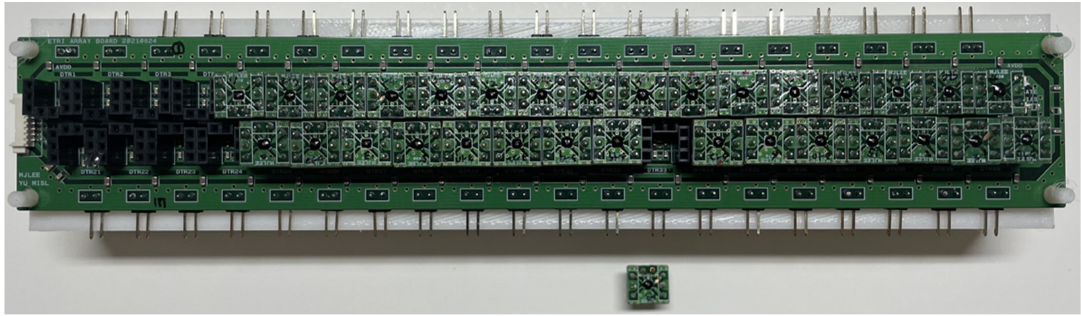
Figure 11. Photograph of the proposed 16 × 2 detector array structure with two columns.